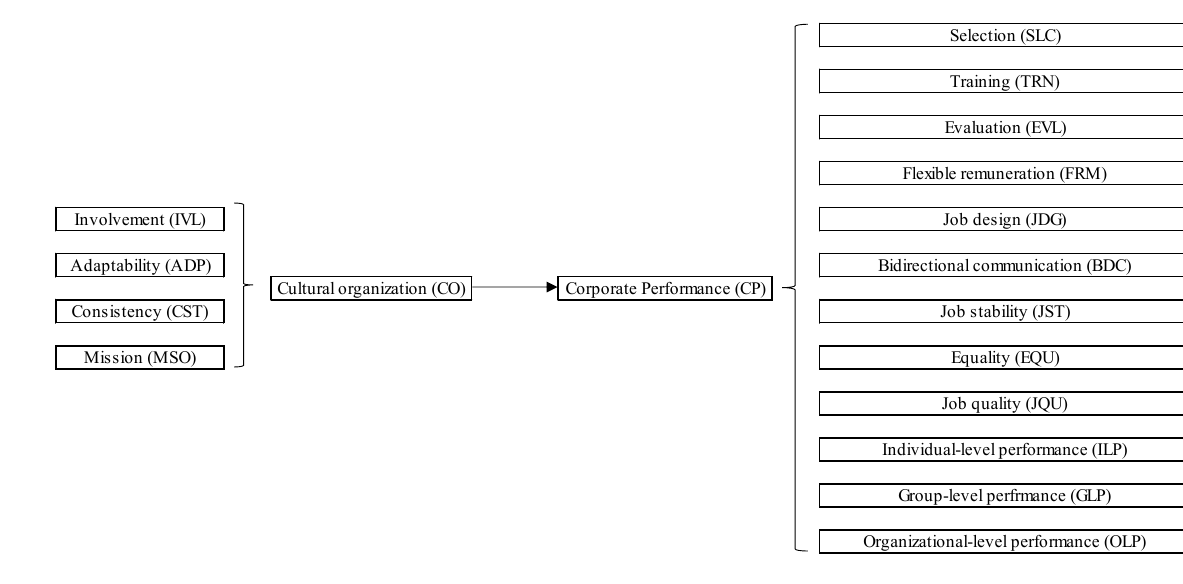
Figure 1. Model based on organizational culture and corporate performance.